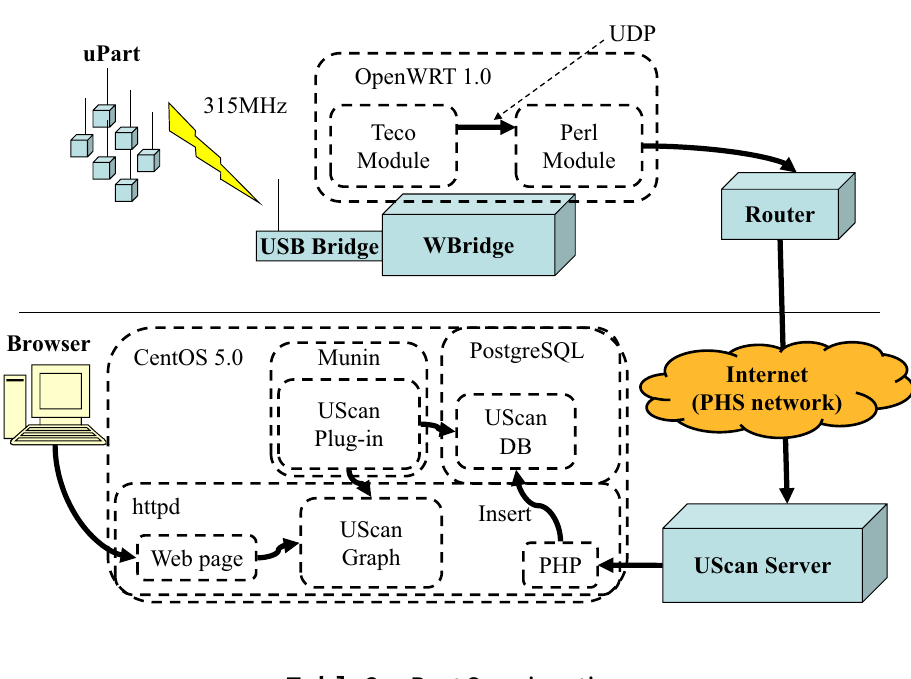
Figure 1. System architecture of UScan.